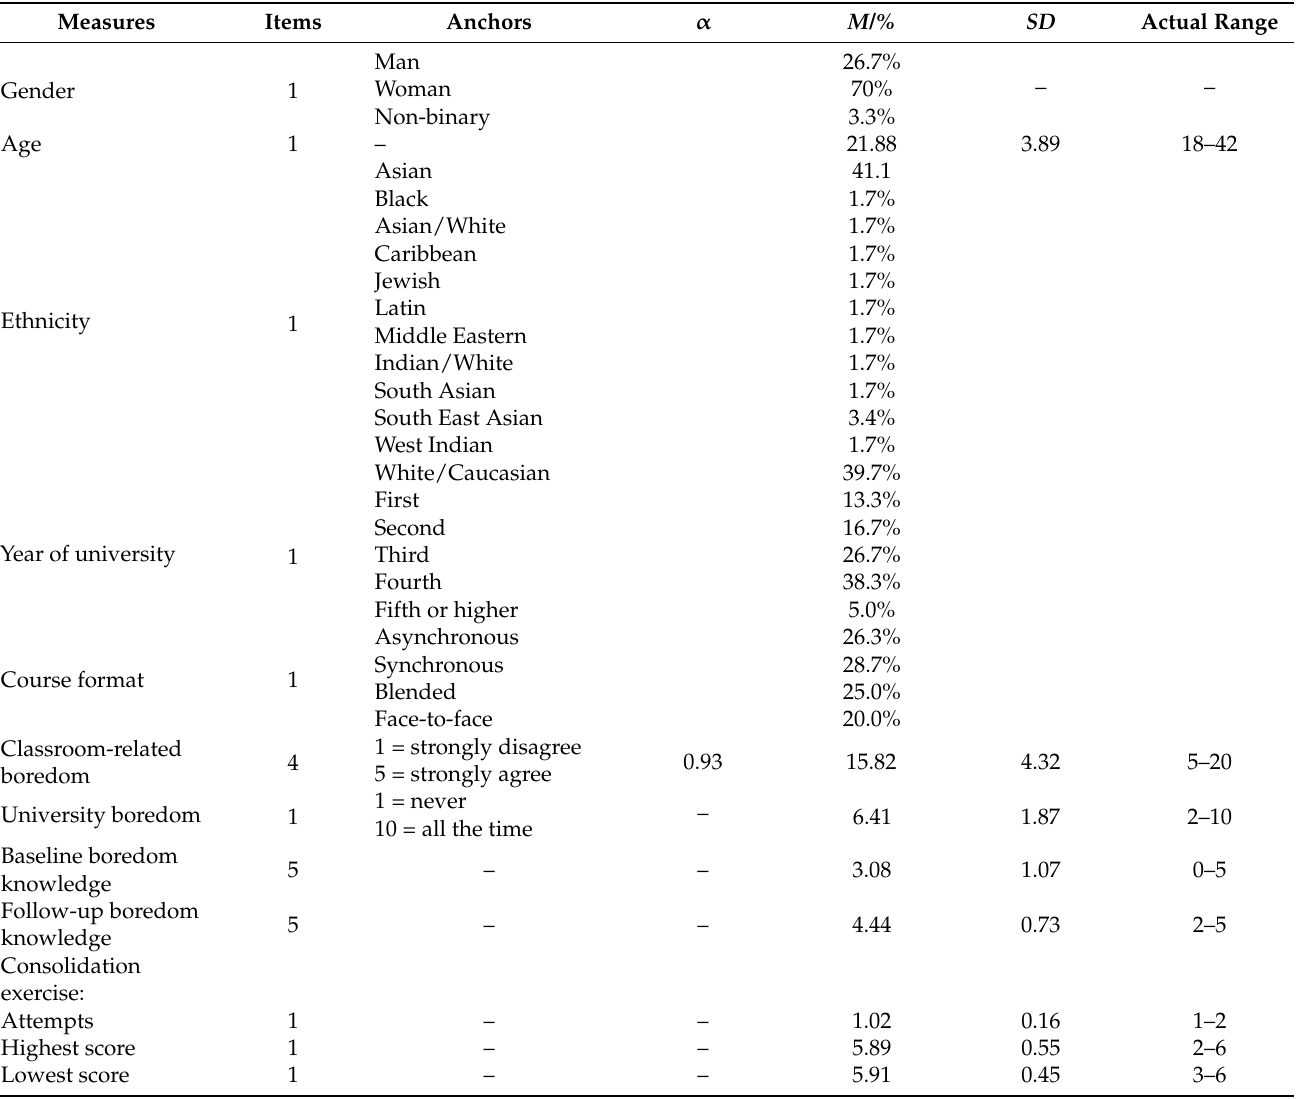
Table 1. Summary of the study